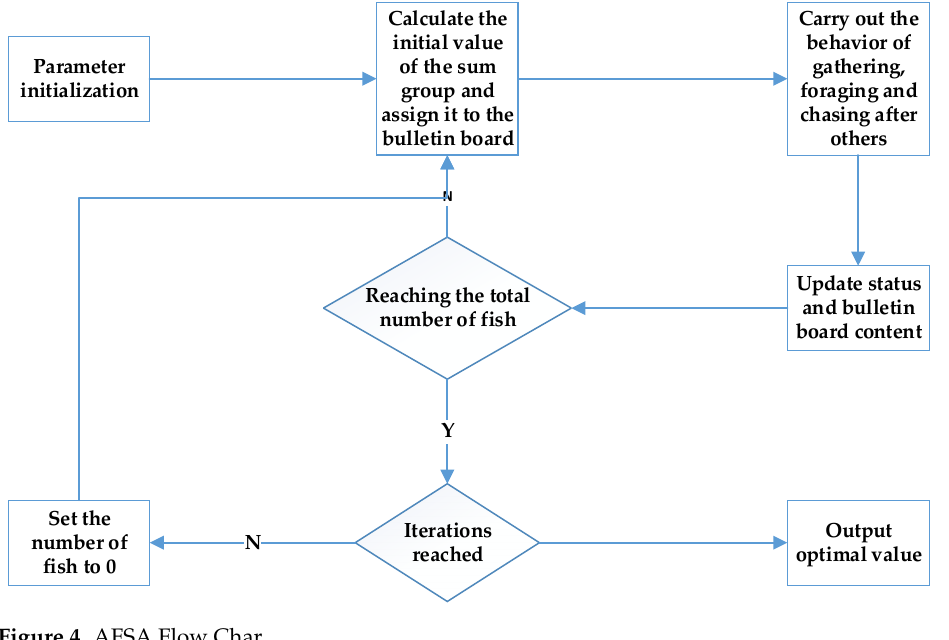
Figure 4. AFSA Flow